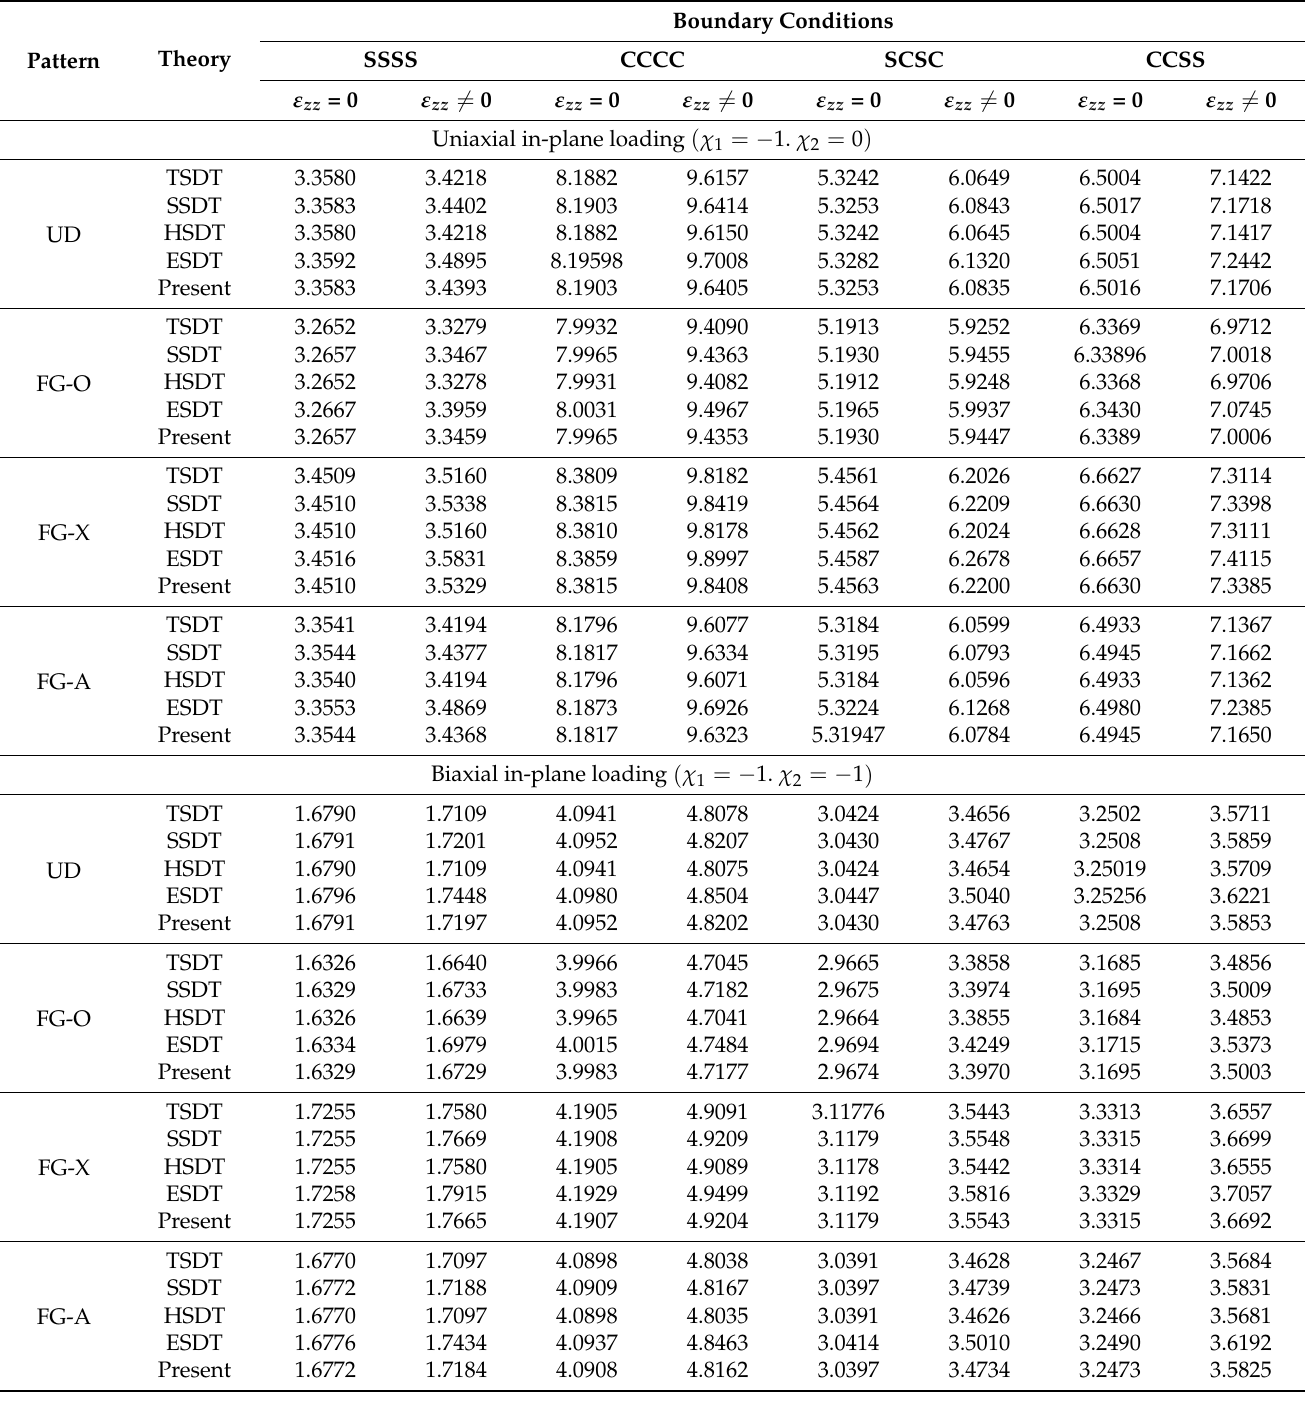
Table 6. Dimensionless critical buckling load of GRNC plate under various boundary